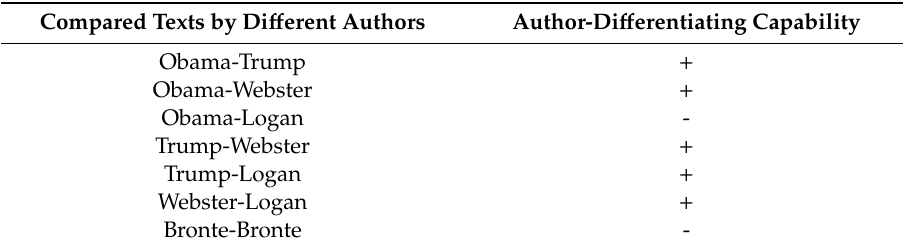
Table 3. The author-di ff erentiating capability of the sonorous phoneme